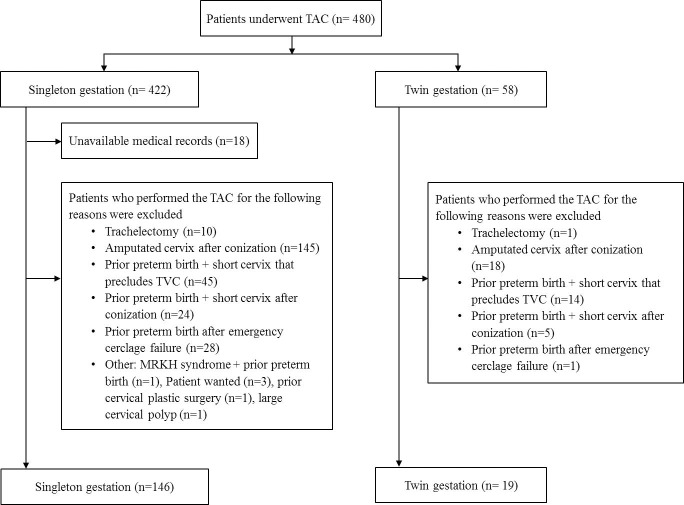
Detailed reasons of exclusion and number of patients who underwent transabdominal cerclage.TAC, transabdominal cerclage; TVC, transvaginal cerclage; MRKH, Mayer-Rokitansky-Küster-Hauser.